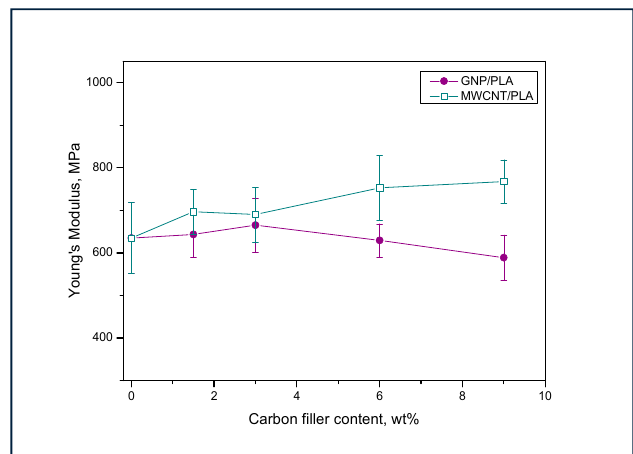
Figure 9. Tensile test results presenting Young’s modulus vs. carbon nanofiller content for MWCNT/PLA and GNP/PLA composites.